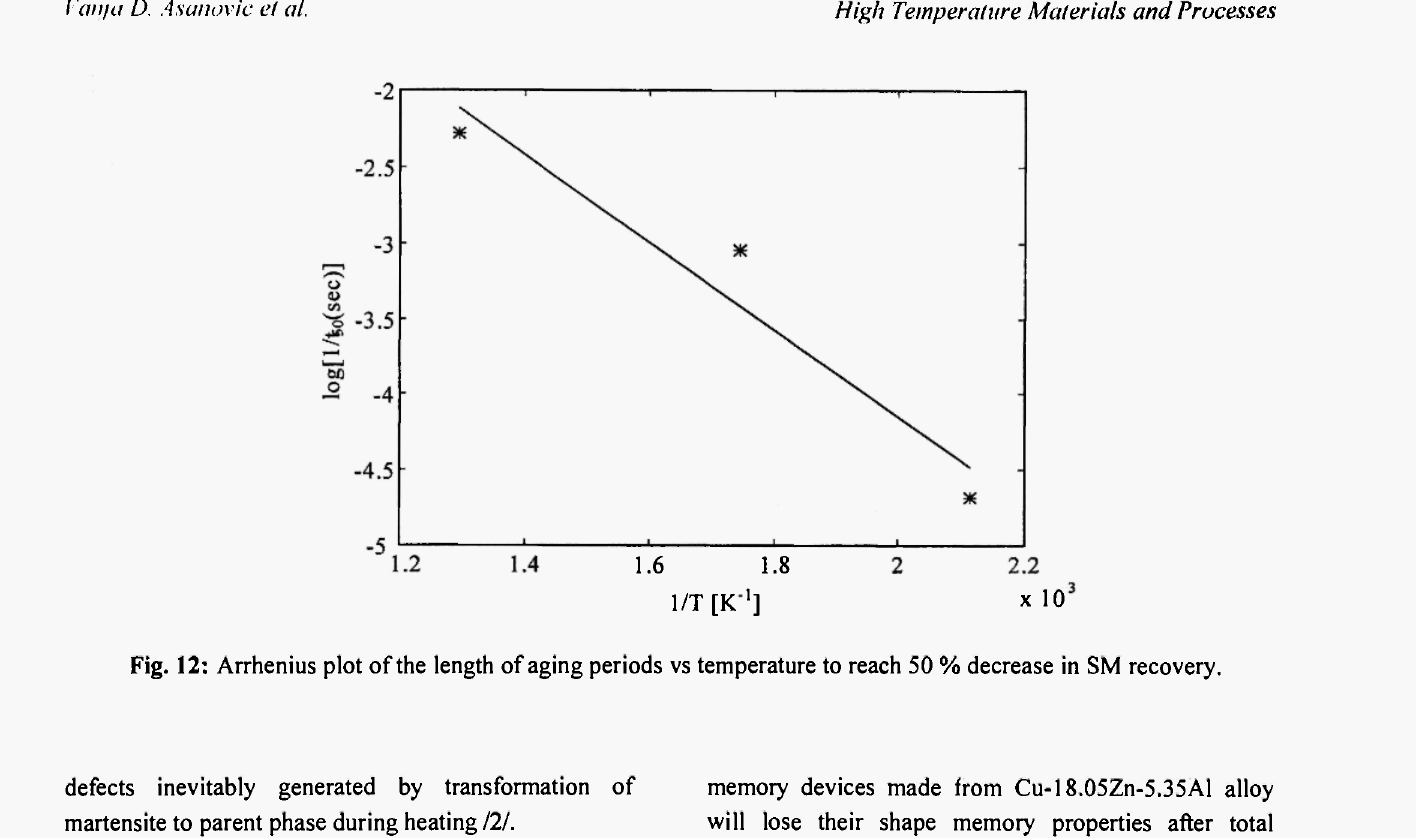
Estimated life of Cu-18.05Zn-5.35Al shape memory alloy (on the base of developing a microstructure with 25% volume fraction of